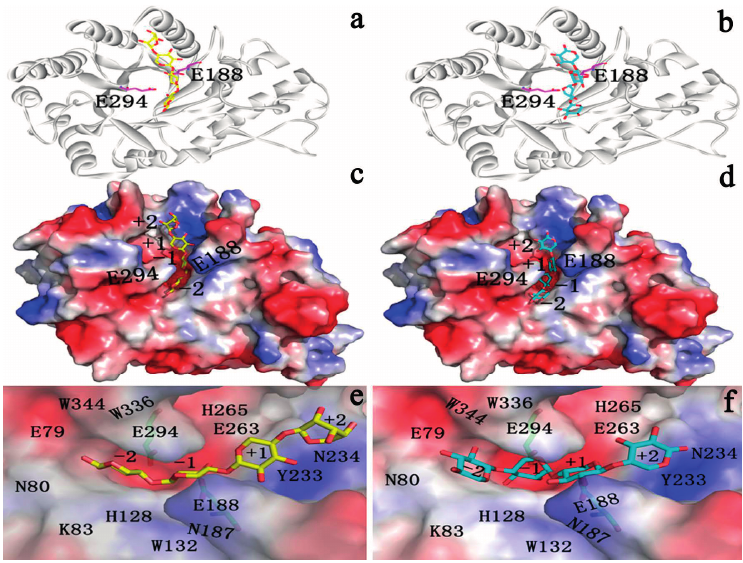
Figure 8. The docked complex. All α -helices and β -sheets are colored in white, and two catalytic glutamates (E188 and E294) are shown as sticks. ( a ) X4(sb)–Xyn10A complex; ( b ) X4(c)–Xyn10A complex ( c ) Surface representation and xylotetraose-binding mode of ( c ) X4(sb) in Xyn10A ( d ) X4(c) in Xyn10A. The protein is shown using the molecular electrostatic surface, with red for negative charge and blue for positive charge. Residues involved in the substrate-binding tunnel are labeled; ( e ) X4(sb) in Xyn10A; ( f ) X4(c) in